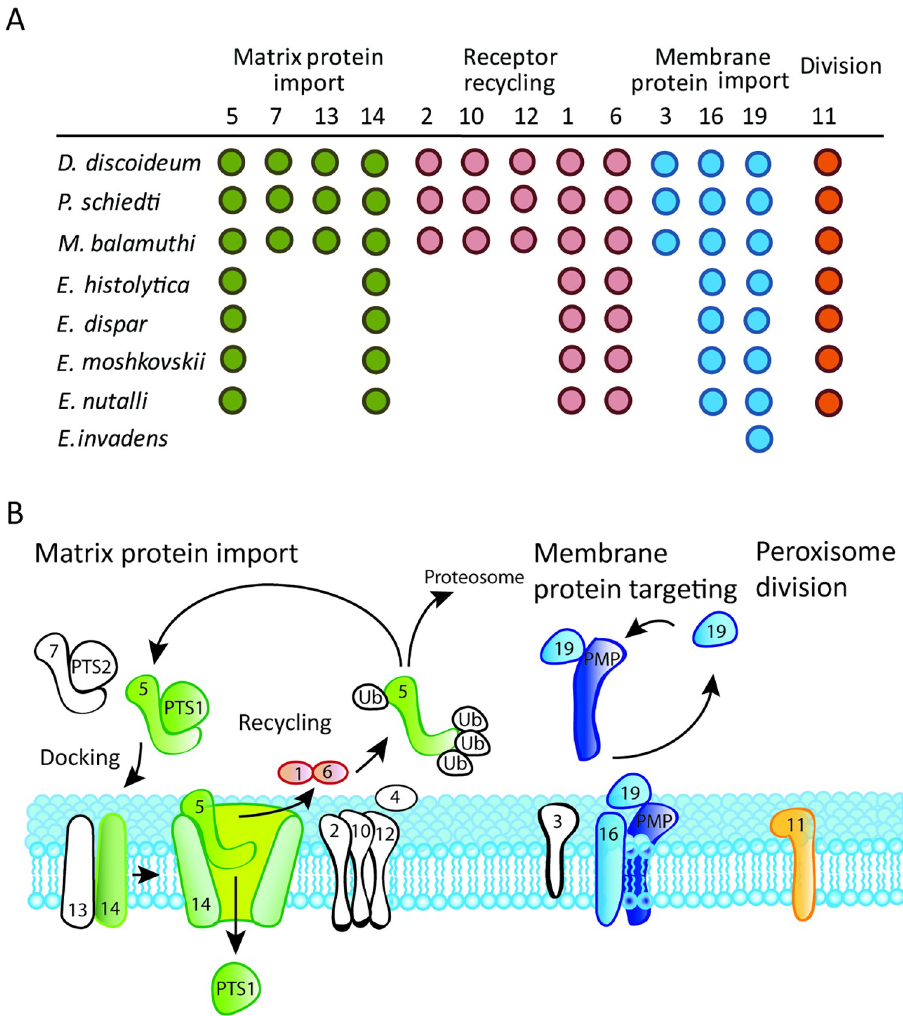
Fig 1. Prediction of PEX coding genes. A. Predicted PEXs in E . histolytica and related Evosea species. B. Scheme of the peroxisomal machinery identified in Entamoeba species except for E . invadens . The white color indicates PEXs that were not identified. Ub, ubiquitin; PMP, peroxisomal membrane